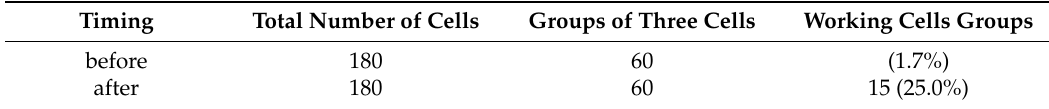
Table 5. Real condition of the cells, with bypass diodes, before and after dehumidifying the 10 modules. Timing Total Number of Cells Groups of Three Cells Working Cells Groups before 180 60 (1.7%) after 180 60 15 (25.0%)